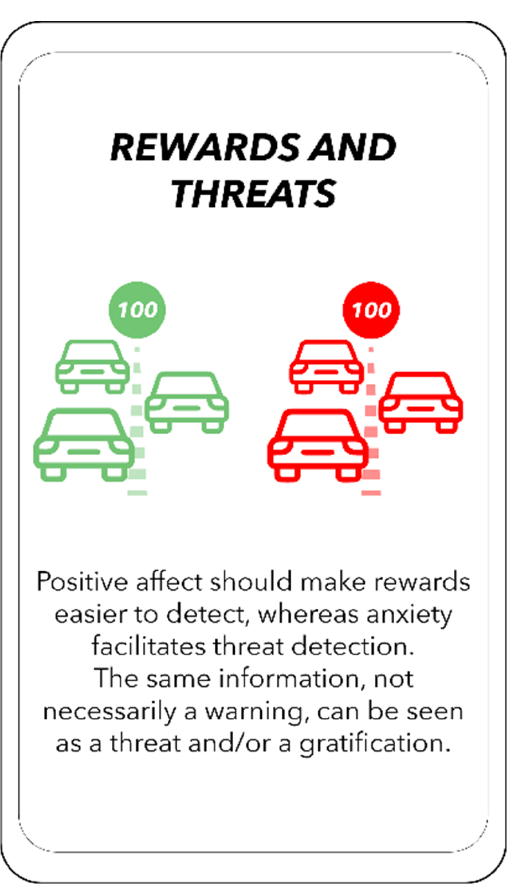
Figure 2. Example of cards structure.